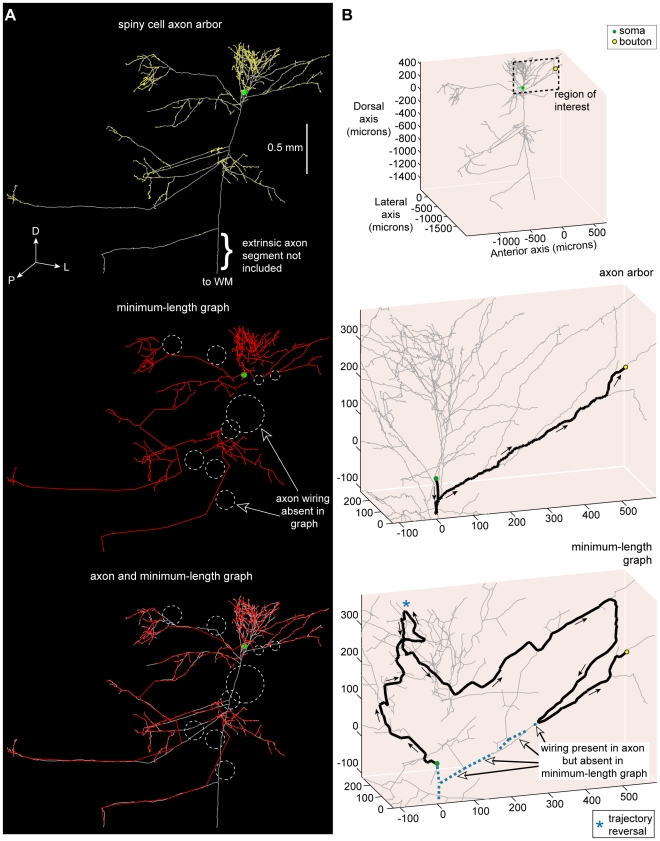
Spiny cell axon arbor wiring compared with minimum-length tree.(A) Example putative excitatory pyramidal cell axon arbor (coronal view) showing the location of numerous boutons (upper), its Euclidean Steiner Minimal Tree (ESMT) graph (middle), and overlay of axon arbor and graph (lower) with dotted circles (white) showing locations where axon wiring was absent in minimum-length graph taken to connect same bouton set. (Key: axon wiring  =  grey lines, graph wiring  =  red lines, axonal bouton  =  yellow dots, cell body  =  green dot; anatomical axes: D, dorsal; L, lateral; P, posterior.) (B) Example of the shortest path from axon origin (root vertex) of this neuron to a selected bouton (upper, see region of interest) for the biological arbor (middle) was, after branching from the main descending axon, fairly direct (0.85 mm path length) but for the length-minimized tree (lower) the route was more circuitous (2.63 mm path length), including a trajectory reversal (marked by blue asterisk), because the artificial arbor lacked wire present in the axon arbor (dotted blue lines). Arrows show direction of flow from axon origin to bouton. (Key: shortest path  =  thick black lines, unvisited arbor wiring  =  grey lines, axon wiring absent in graph  =  dotted blue lines.).